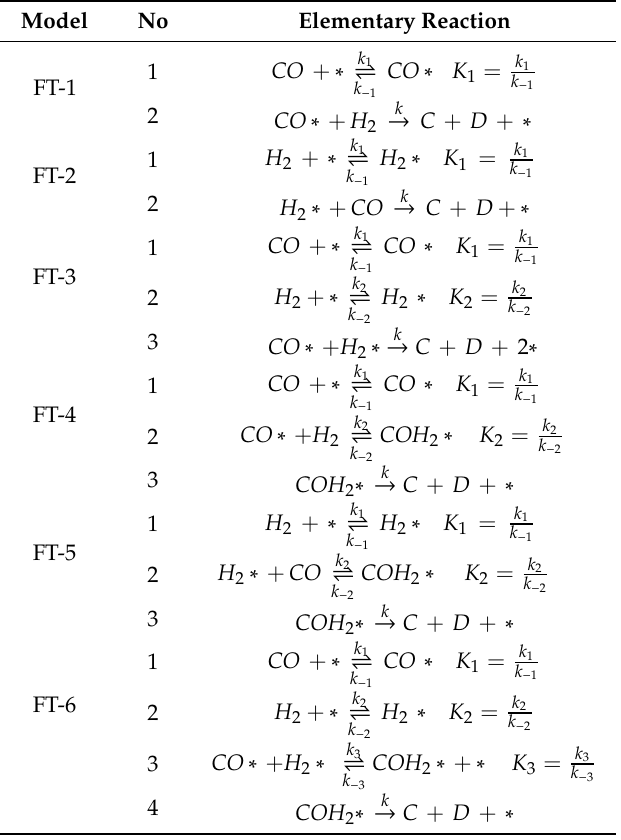
Table 2. Elementary reaction steps for Fischer–Tropsch